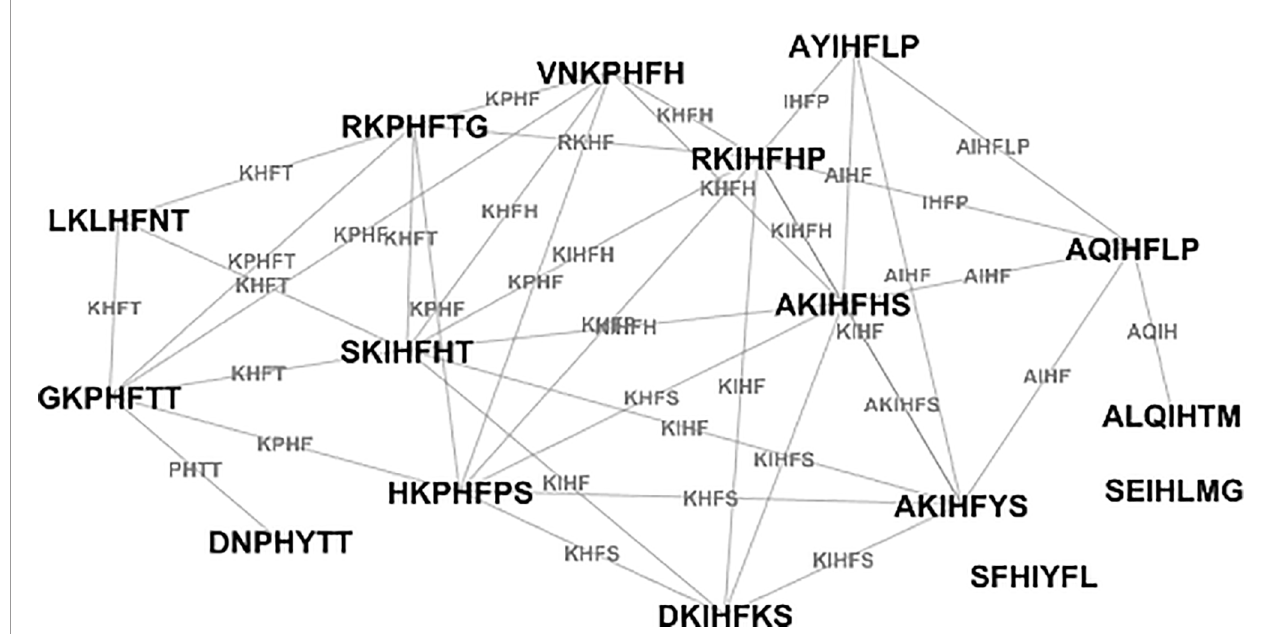
FIGURE 4 | A typical graph of the sequences of mimotopes of a single monoclonal – example based on the SA-7 anti-Fas antibody (49). The edge names are the respective longest common subsequences.